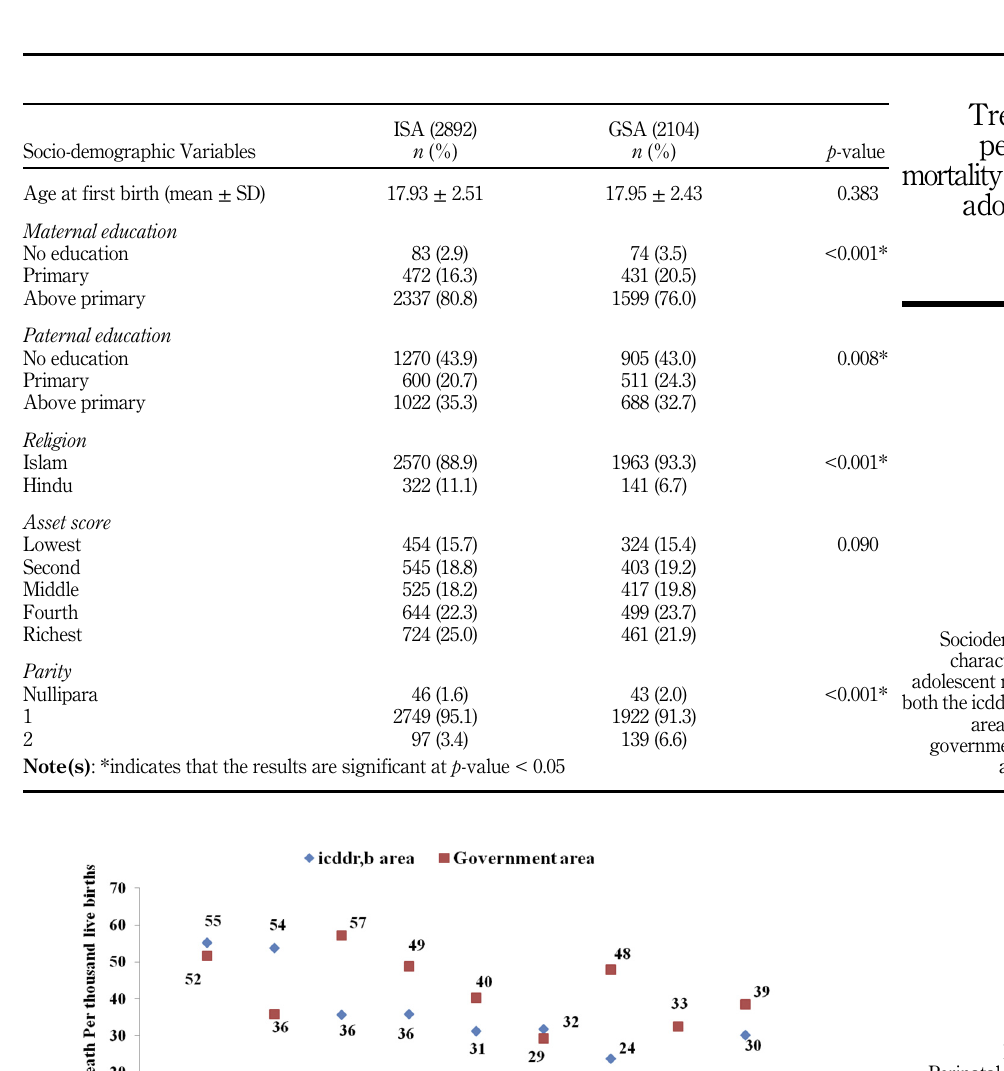
Figure 2. Perinatal death rate between the icddr,b areas and